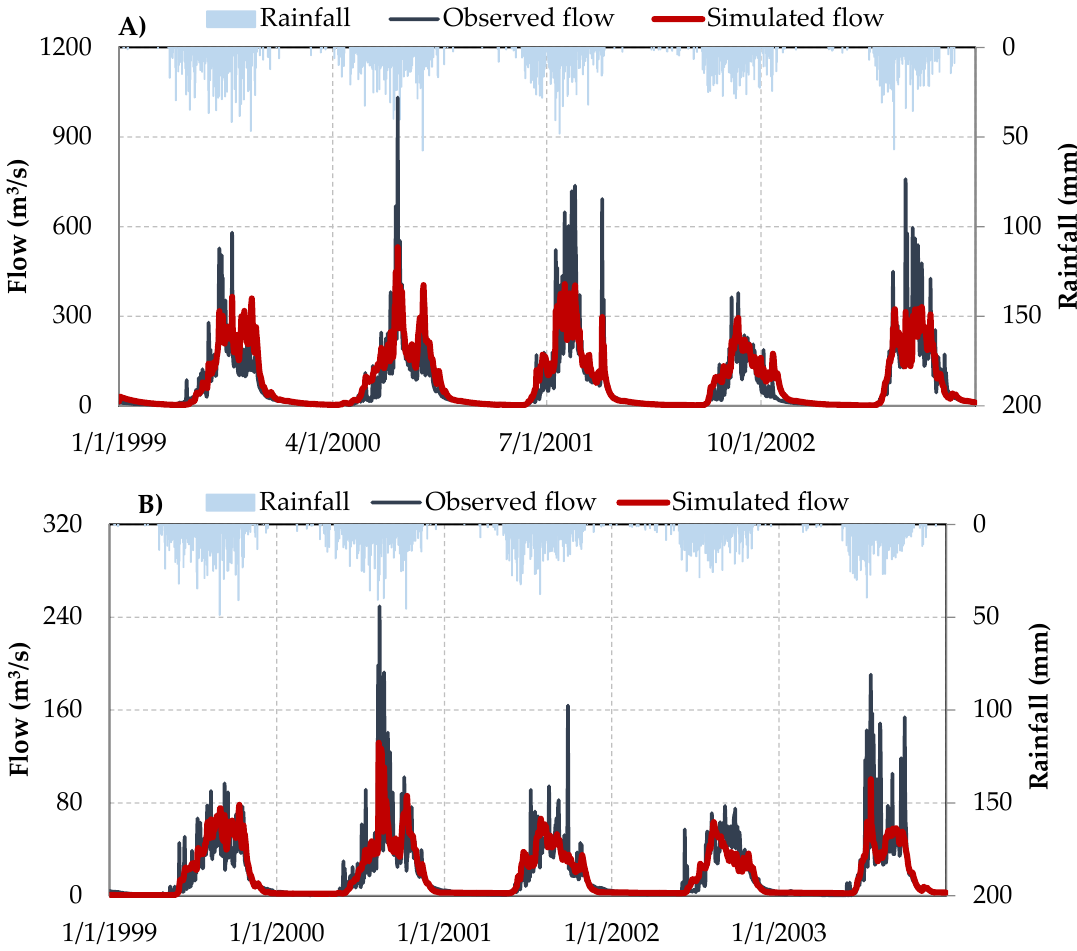
Figure 3. Comparison of simulated and observed flow for the calibration period (1999–2003): ( A ) simulated and observed flow of Main Beles for the calibration period; and ( B ) simulated and observed flow of Gilgel Beles for the calibration period.